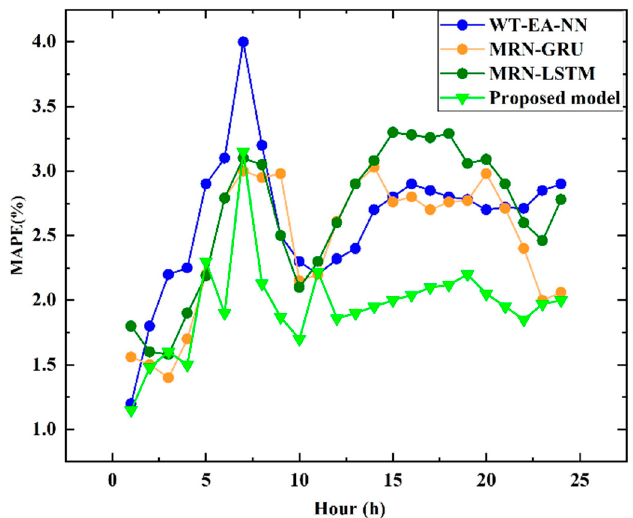
Figure 5. Comparison of hourly MAPE results between the proposed model and other deep learning methods: MAPE, mean absolute percentage error.